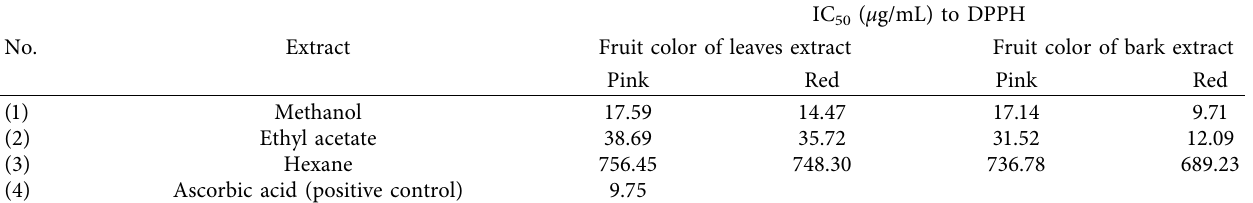
Ascorbic acid (positive control)